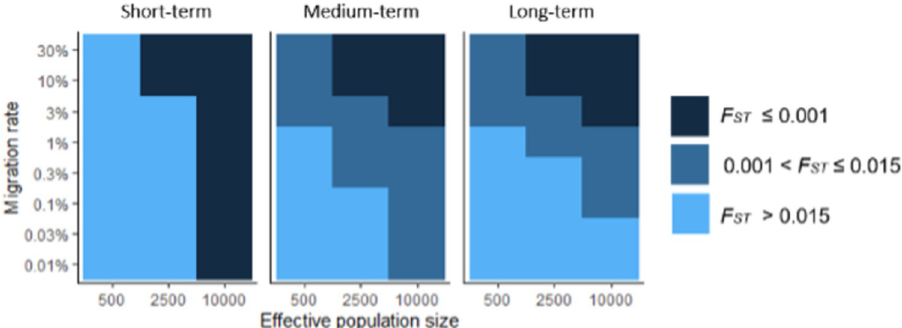
Fig 6. Results of simulations that investigated demographic conditions that reproduced empirical F ST results. Tile maps represent pairwise F ST for each combination of effective population size, migration rate, and number of generations of drift elapsed. Short-term (left) represents results from 10 generations of drift, Medium-term (middle) from 100 generations of drift, and Long-term (right) from 1,000 generations of drift. Tile color is divided into three groups based on the scale of F ST : smaller than the observed F ST values in this study, within the range of observed pairwise F ST , and greater than the observed pairwise F ST